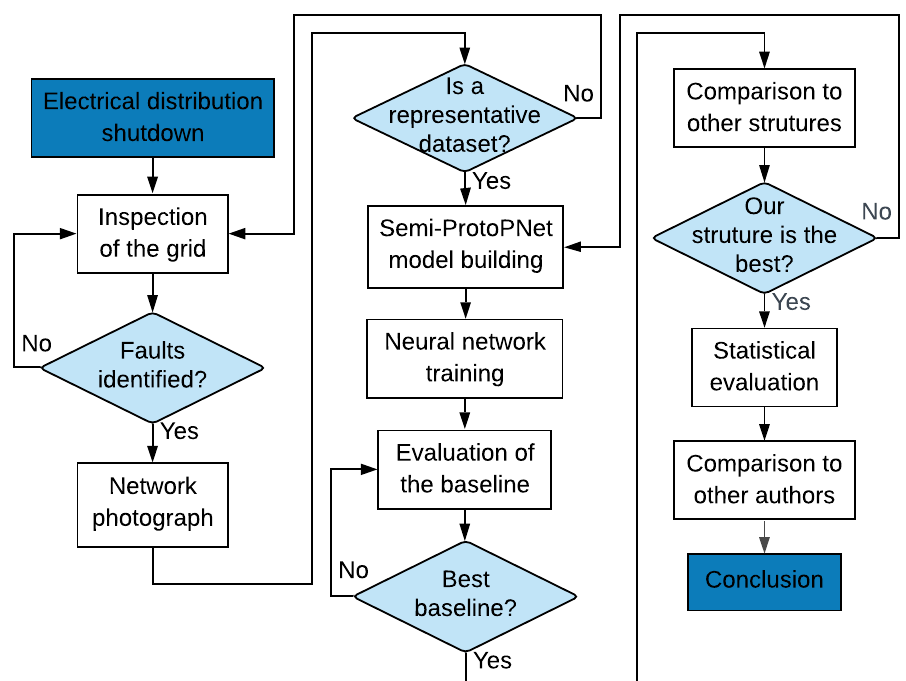
Figure 3. Flowchart of the analysis performed in this